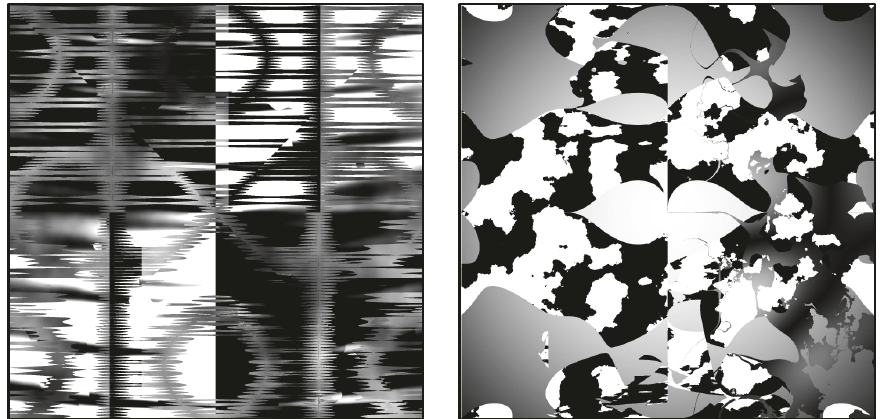
Figure 17:Evolved images with uncomfortable spatial properties.Selection of images with uncomfortable aspectswas performed with images sizedto12”sidelengthsataviewingdistanceof24”(identicalangularspatialfrequenciescanbeobtainedwhenthispageisviewedatadistance of 4.1”, though we suspect that the eye strain induced from close proximity viewing will cause further undue